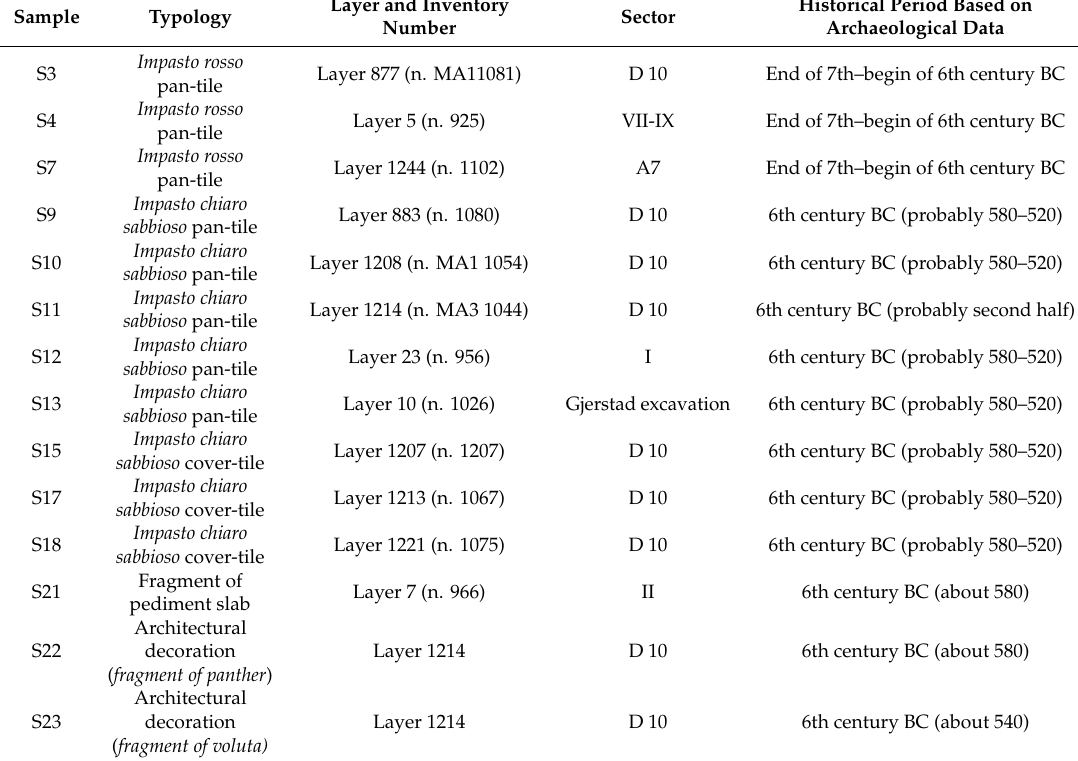
Table 1. Architectural earthenwares coming from the archaeological site of S. Omobono, with typology, layer, provenance area and historical period, based on archaeological